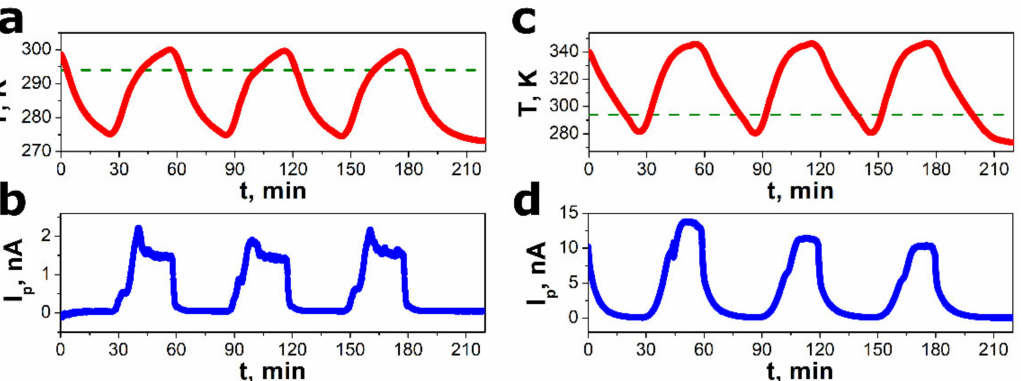
Figure 5. Cyclic changes in temperature ( a , c ) and corresponding output current ( b , d ) of the SbSI–TiO 2 pyroelectric nanogenerator. The green horizontal line represents the value of the Curie temperature T C = 294(2)